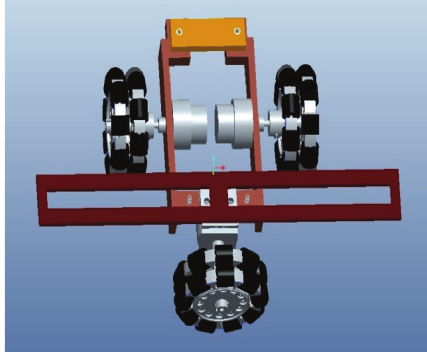
Figure 3: Pro-E design of